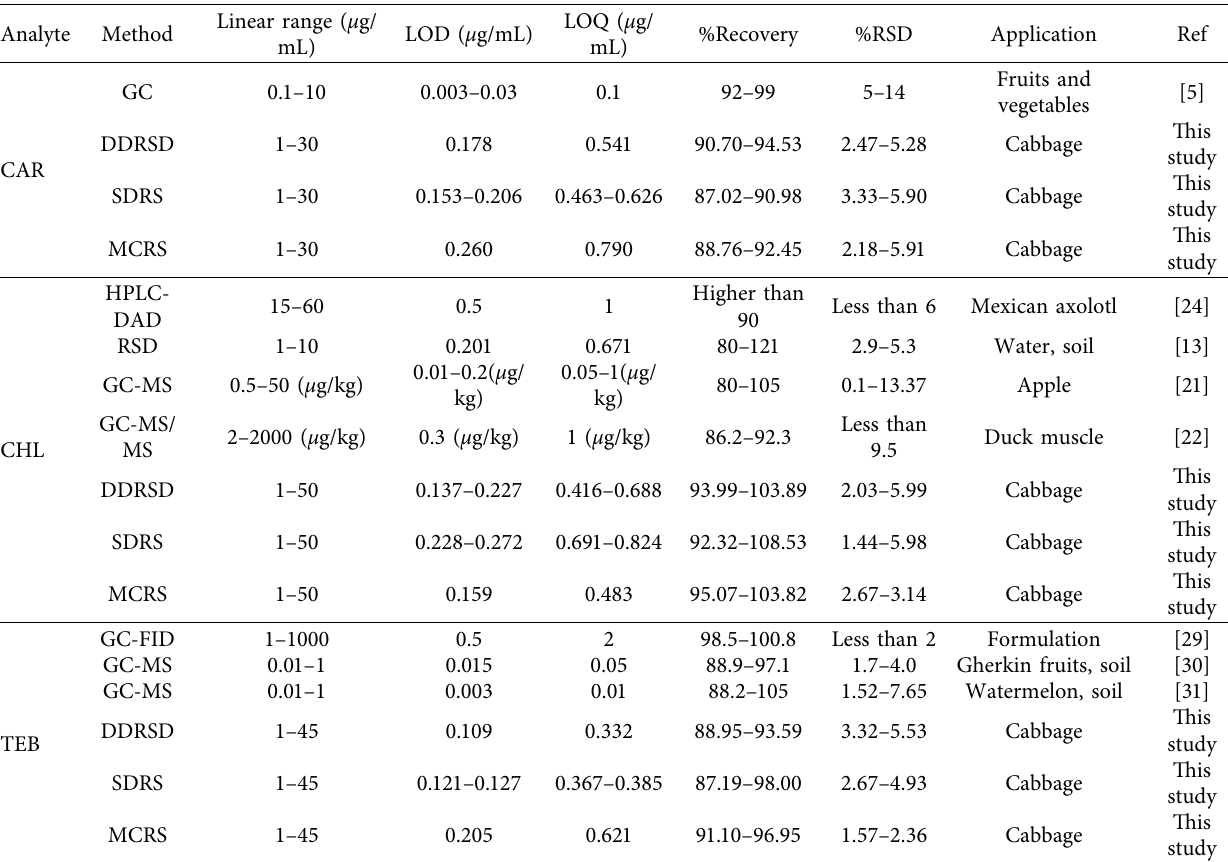
Table 6: Comparison of the published methods with the proposed methods for determination of carboxin, chlorpyrifos, and tebuconazole in real